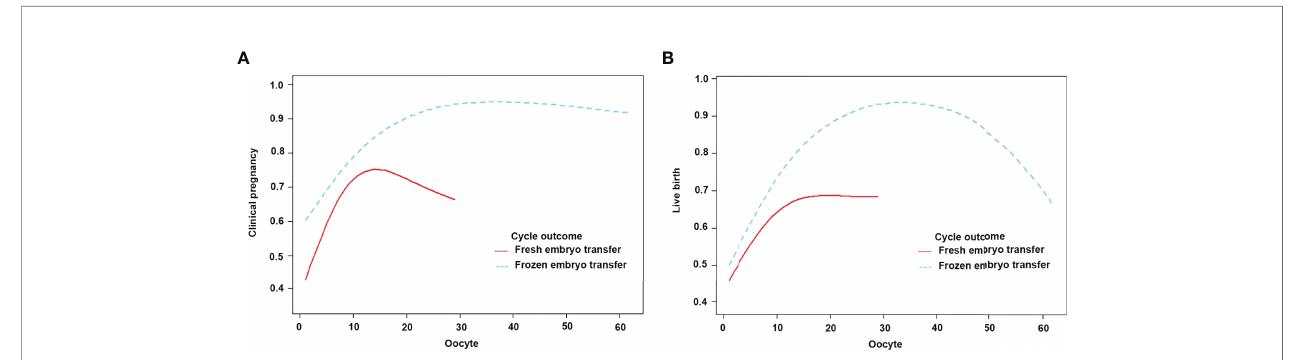
FIGURE 4 | Patients were classi fi ed according to fresh/frozen embryo transfer strati fi cation, curve fi tting between the number of oocytes retrieved, and clinical outcomes. The adjusted smoothed plots between the number of oocytes retrieved with the clinical pregnancy rate and the live birth rate were based on a two- piecewise regression model (A, B) . The red line represents fresh embryo transfer, and the blue line represents frozen embryo transfer. Adjustment factors included age, BMI, bFSH, bE2, dose of Gn, type of PCOS, and years of infertility.